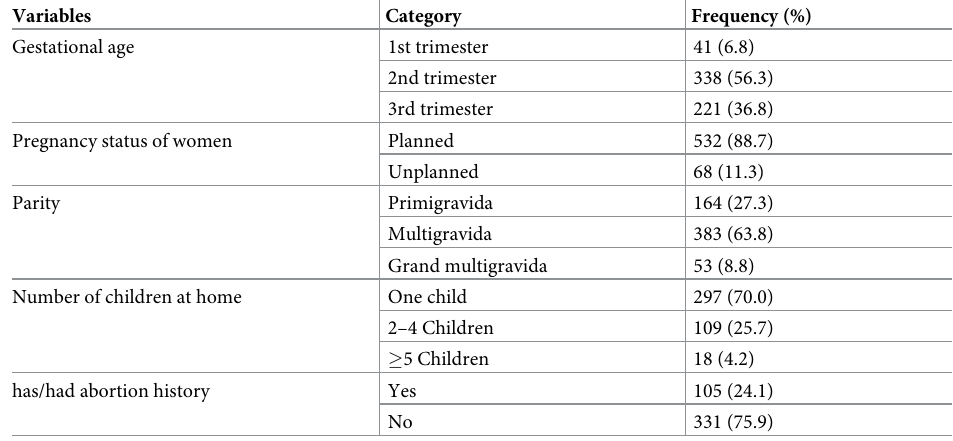
Table 3. Obstetrical characteristics of pregnant women in Hawassa city, Sidama Regional State, Ethiopia, 2021.